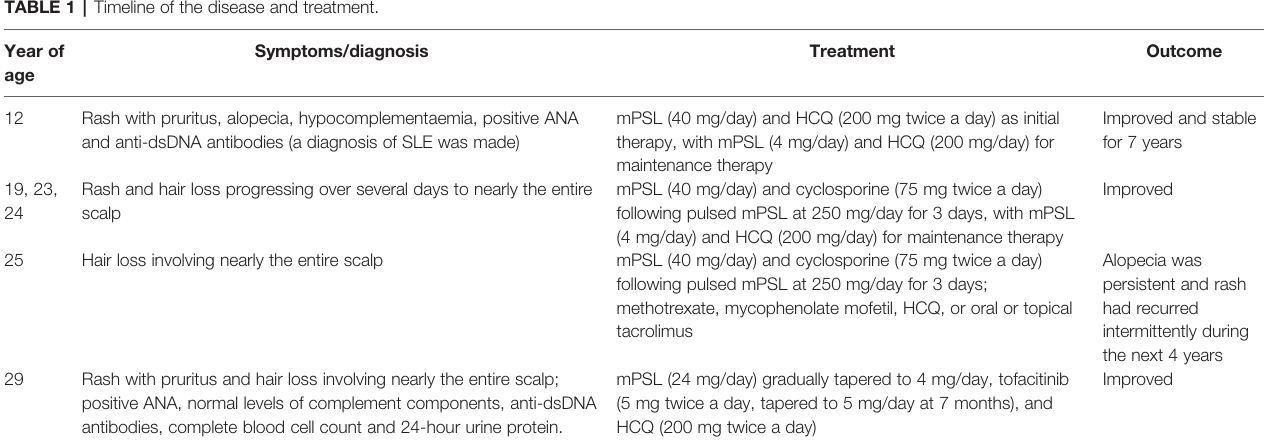
Rash with pruritus and hair loss involving nearly the entire scalp; positive ANA, normal levels of complement components, anti-dsDNA antibodies, complete blood cell count and 24-hour urine